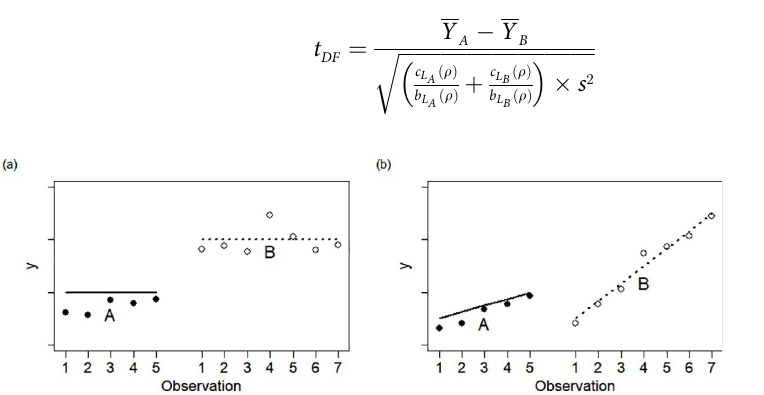
Fig 2. These simulated data represent N -of-1 trials where a series of observations from treatment A are observed first, followed by a series of observations from treatment B. These data may be suitably analyzed with 2-sample serial t -tests for level-change (a) and for rate-change (b). The true means are represented with lines, and serially correlated observations with points.